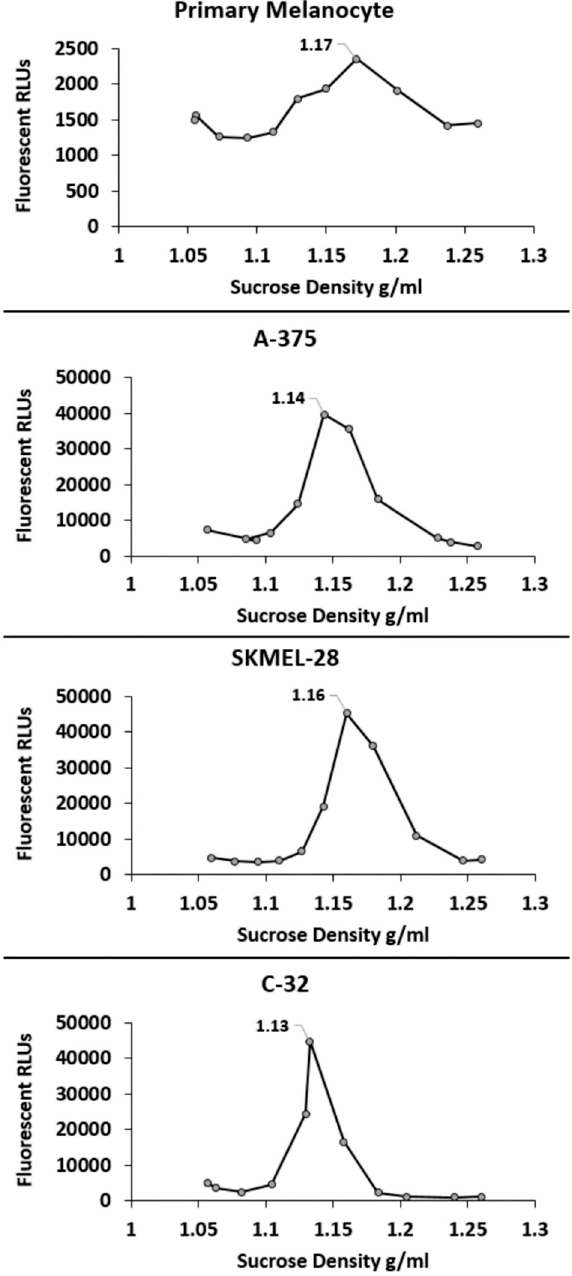
Figure 2. Density characterization of primary melanocyte sEVs and melanoma sEVs. Representative sucrose density gradients are shown. RLU = relative light units corresponding to sEV carbocyanine DiI signal. Peak sEV density is labeled on each gradient.